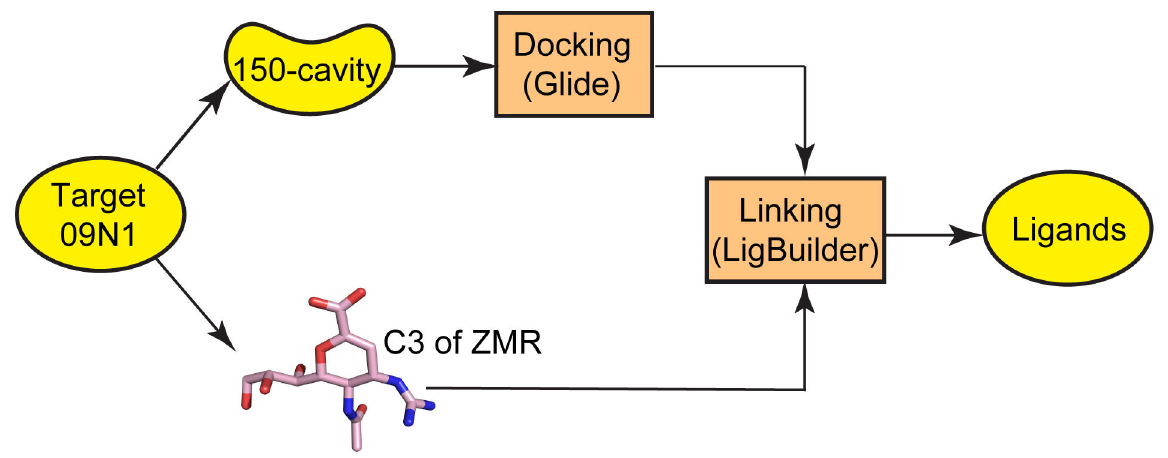
Figure 1. Workflow of the combined method. Workflow of the combined method for selecting drug-like candidates which target the 150-cavity of 09N1. First, selecting fragment candidates through virtual screening based on the structure of 150-cavity in 09N1. Second, linking fragment candidate and scaffold ZMR through C-3 position of ZMR by LigBuilder software. Finally, the successfully linked molecules were tested through MD simulations to testify the stability of the molecules in the binding pocket of 09N1. doi: